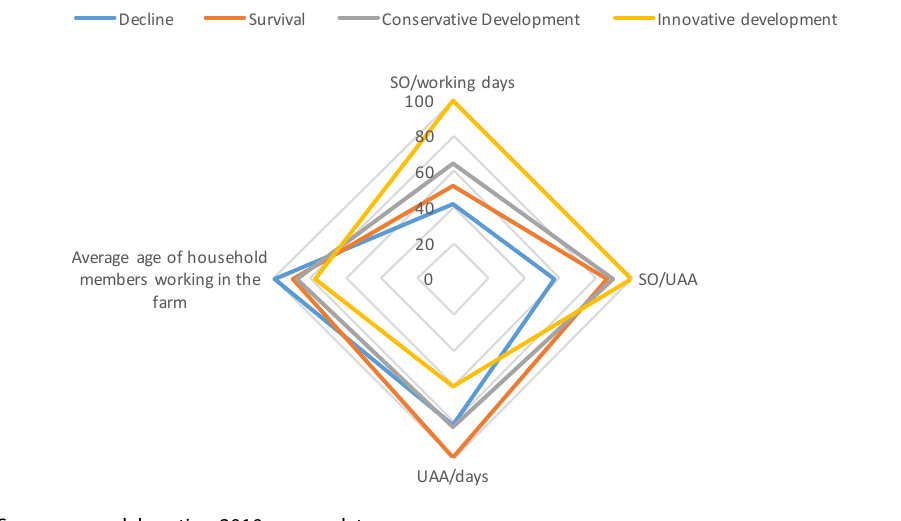
Table 12 . Mugello - Farming styles distribution by Tuscany RDP zones. Farms Number and Hectares of TAA.